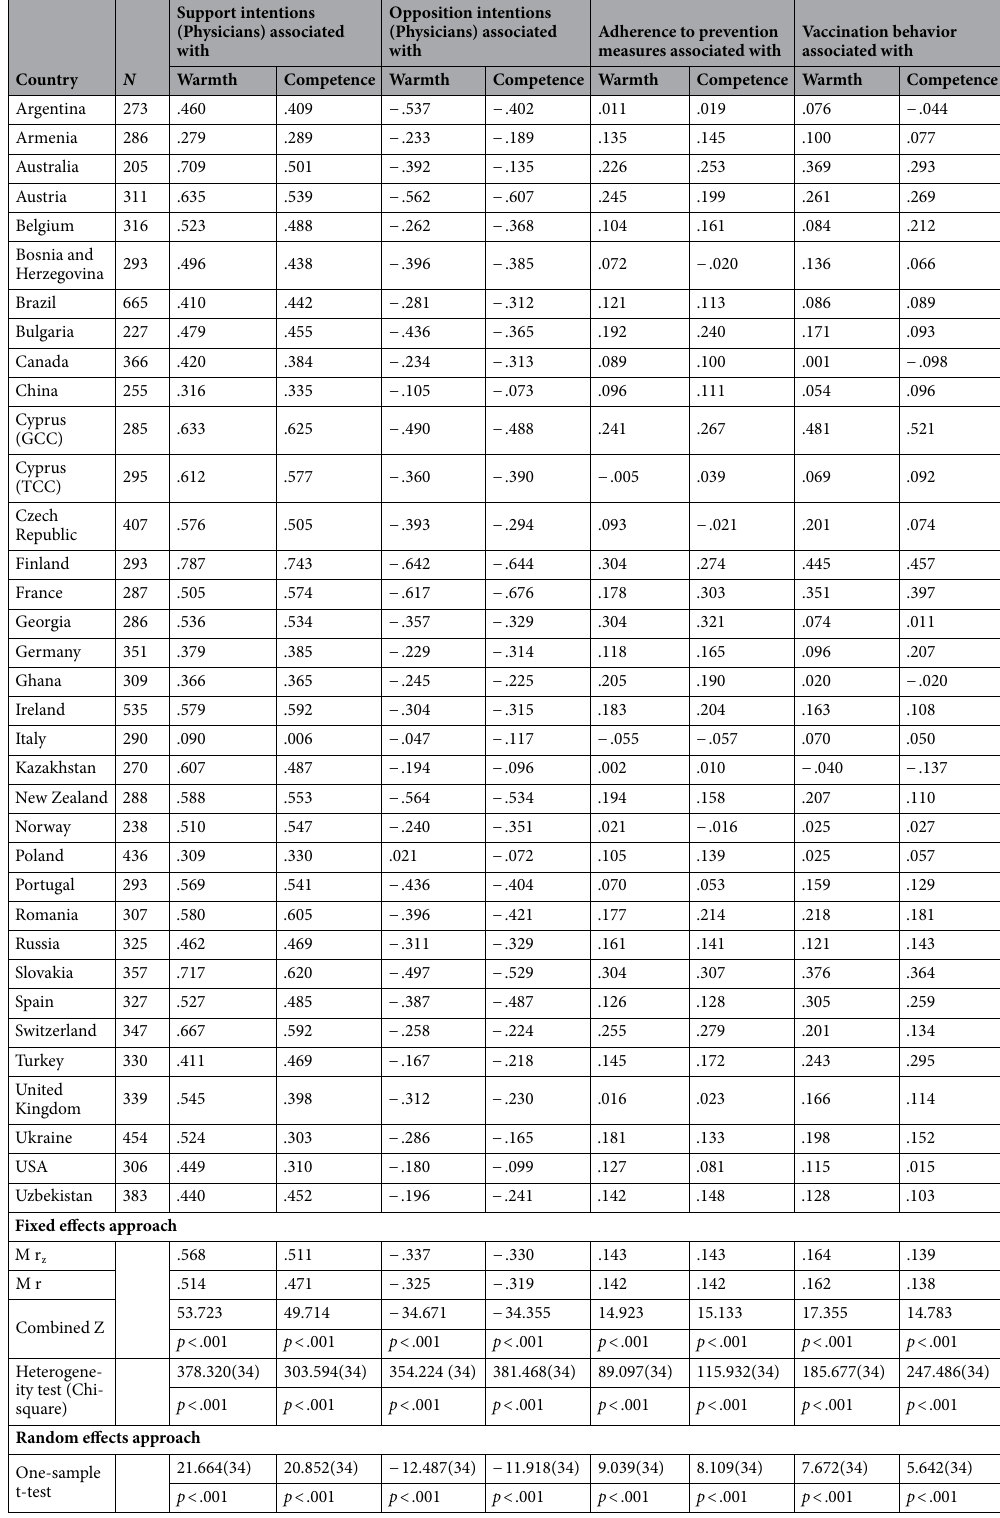
Table 2. Relationships between warmth and competence perceptions of the protagonist ‘physicians’ with pandemic-related behavioral intentions and behaviors within and across 35 countries. TCC